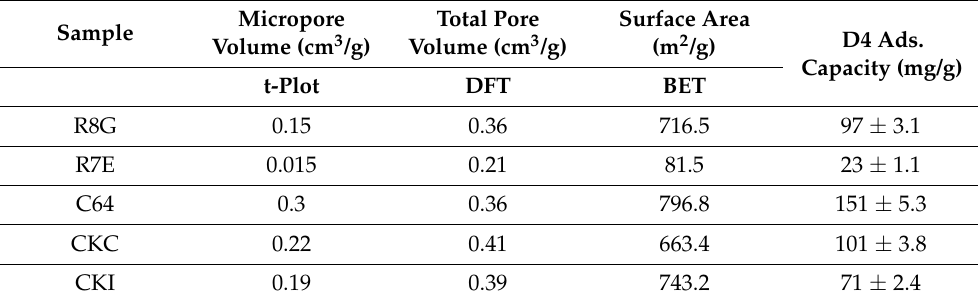
Figure 4. Micropore volume correlation with D4 adsorption capacity. Figure 5 illustrates the siloxane D4 adsorption capacity related to the total pore volume of the materials.